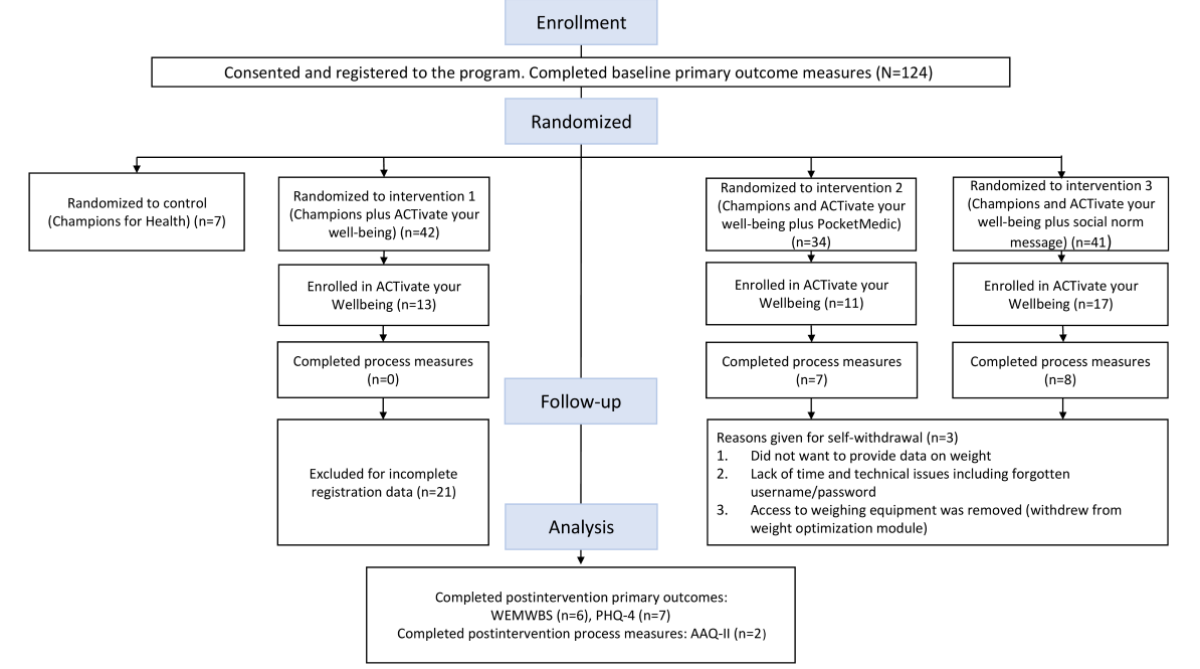
Table 1. Participant characteristics (n=103).